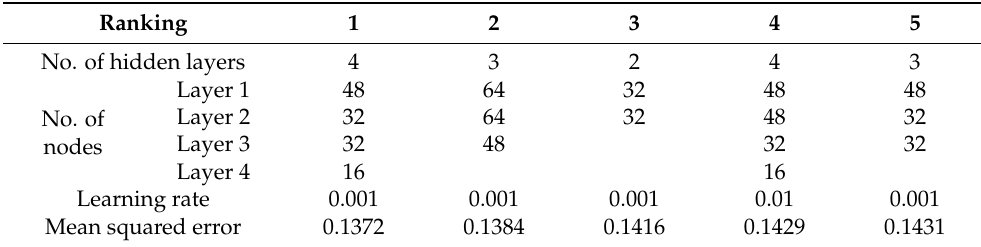
Table 2. Top 5 model structures in the hyperband